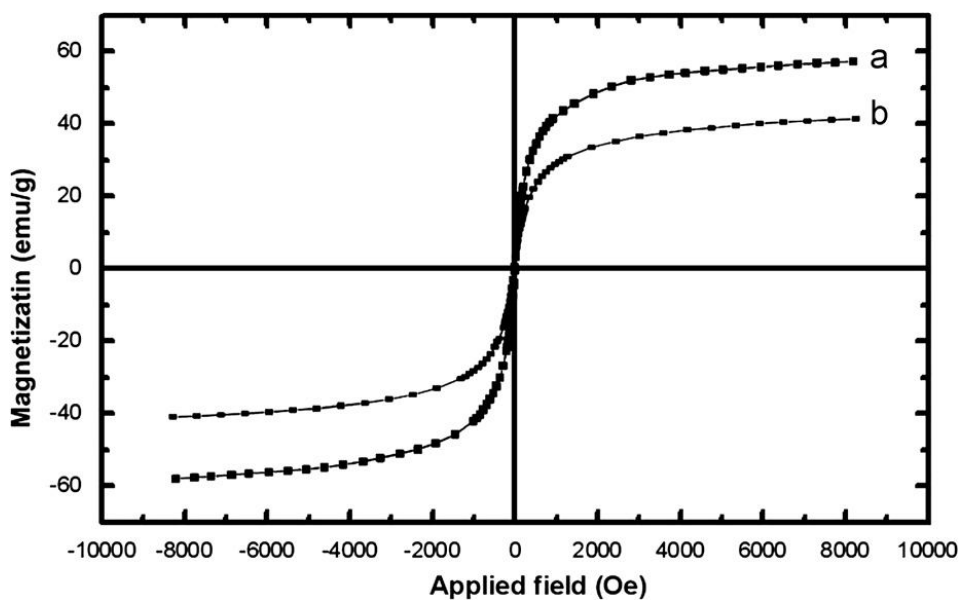
Fig. 5. Magnetization curves of (a) MNPs and (b) Si-Im-HSO